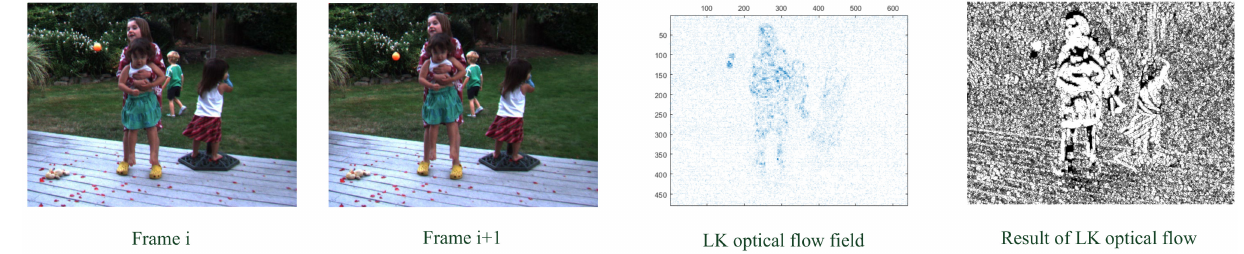
Figure 6. The object motion detection in color image sequence with the LK optical flow method.